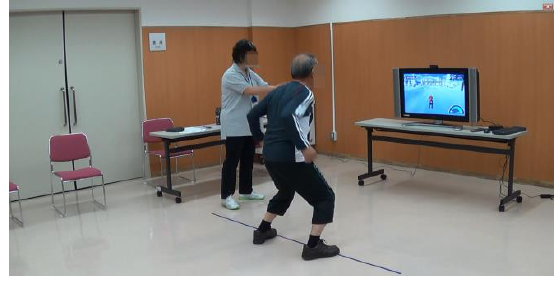
Figure 4. The usability testing of the Skiing game with a Japanese elderly